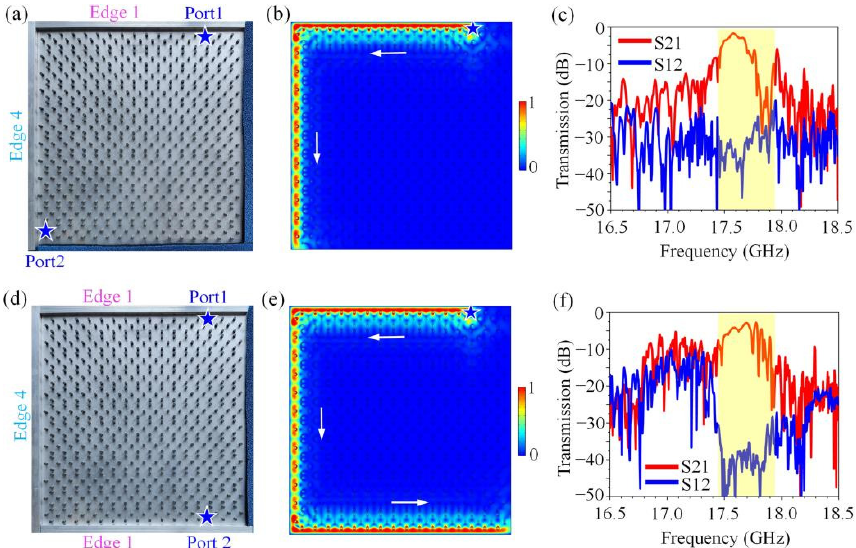
Figure 4. Topological transmission lines composed of Edge 1 and Edge 4. ( a , d ) Photos of experimental samples. The metallic strips were placed near the boundaries of GPC to form the transport channels, and the microwave absorbers were utilized to avoid the reflection of EM waves. ( b , e ) Simulated electric field distribution excited by a line source. The blue star is the line source and the white arrow indicates the direction of electric field transmission. ( c , f ) Measured transmission spectra of topological resistance-free transmission lines. There existed a big contrast (about 35 dB) between parameters S21 and S12 at 17.45~17.95 GHz.